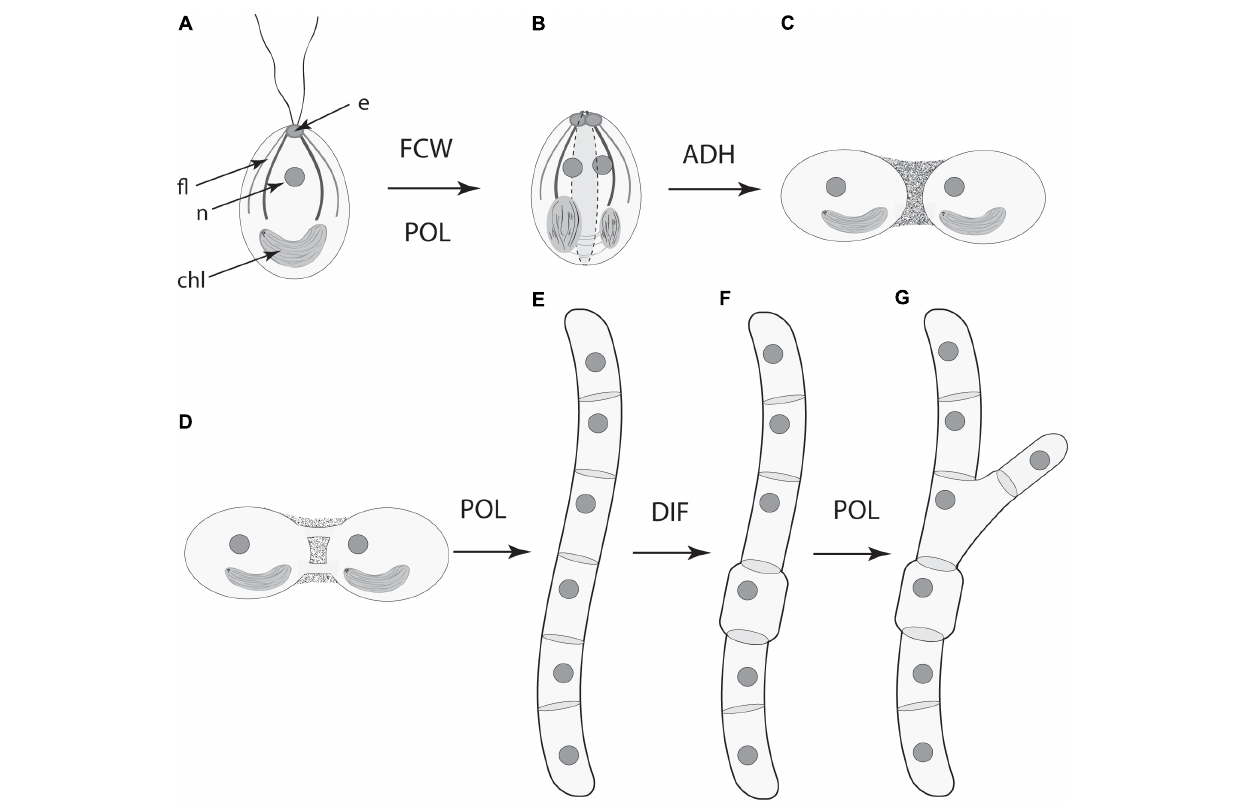
FIGURE 7 | Serial schematic of the ways four DPMs have contributed to the evolution of complex multicellularity in the land plants (see also, Figure 5 ). (A) The ancestral unicellular condition within the Streptophytes (the green algae and the land plants) with a flagellar apparatus and associated eyespot, nucleus, and parietal chloroplast. (B) The future cell wall (FCM) module operates along the longitudinal cell axis in conjunction with the polarity (POL) module to specify the plane of cell division (dashed lines). (C) The cell-to-cell adhesion (ADH) module establishes the colonial body plan (show here by two adjoining cells). (D) Symplastic continuity between adjoining cells is established by means of plasmodesmata. (E) The POL module shifts the frame of reference for the FCW module (now orthogonal to the cell longitudinal axis) to form an unbranched filament. (F) The differentiation (DIF) module is deployed for the evolution of specialized cells. (G) The POL module operates to now specify a second plain of cell division to produce a branched filament. The role of the POL module in establishing a third plane of cell division (and thus the development of parenchyma) is not shown here. e, eyespot; fl., flagellar apparatus; n, nucleus; chl,